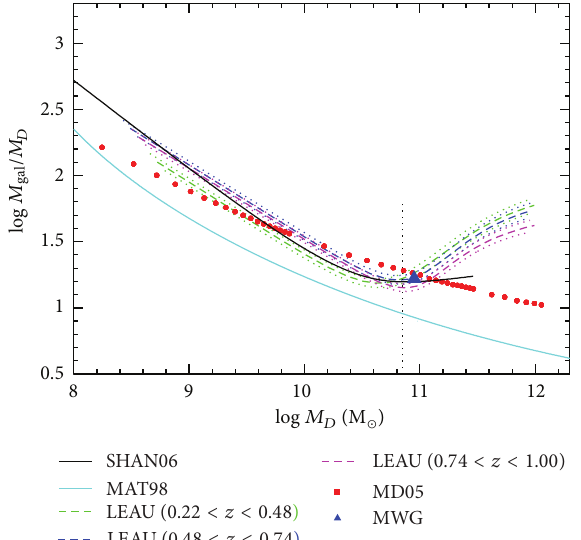
/𝑀 Figure 3: The ratio 𝑀 𝐷 as a function of the mass in the disk gal 𝑀 𝐷 . Our models results are the solid red dots. The cyan and black lines are the results obtained by Mateo [95] and Shankar et al. [96] from observations of the local group of galaxies and from halo data, respectively. Magenta, blue, and green dashed lines are results from Leauthaud et al. [97] for different ranges of redshift as labeled. The MWG point is represented by a blue full triangle and the dotted black line marks the limit between disk and spheroidal galaxies from Gonz´alez Delgado et al. [98].